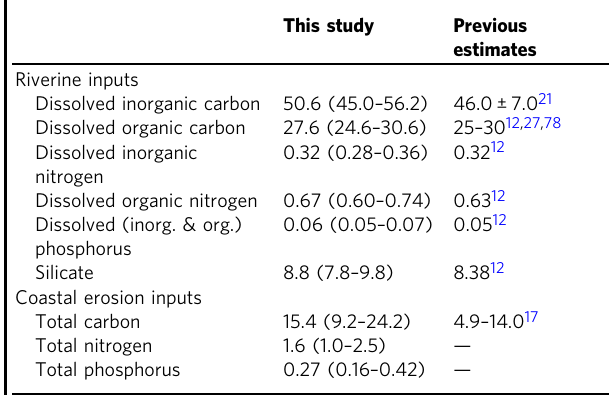
Table 1 Annual carbon and nutrient fl uxes from rivers and coastal erosion with one standard deviation provided in brackets (see